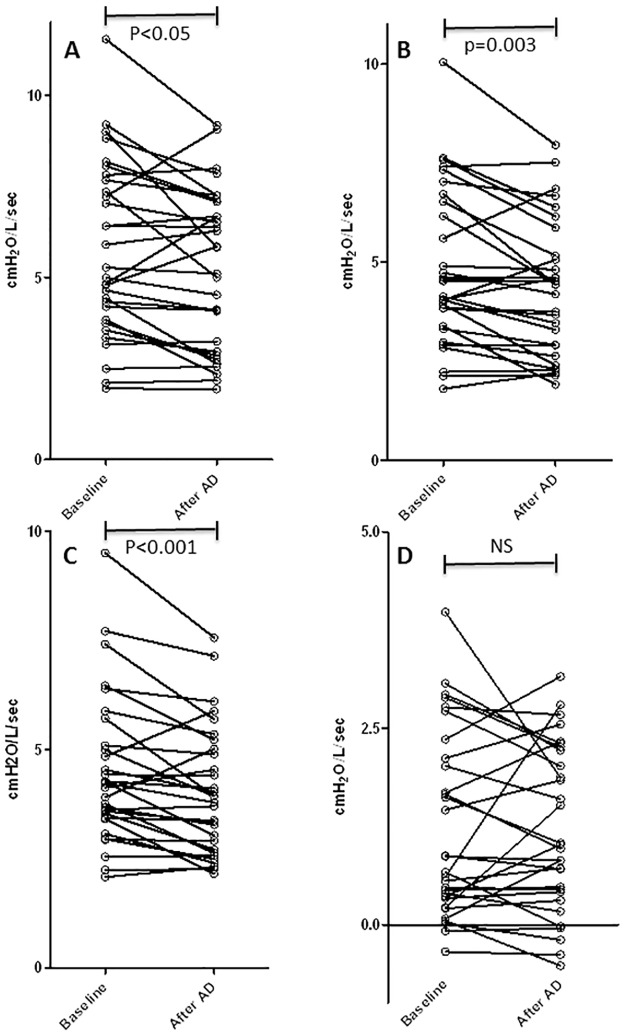
Individual values of inspiratory resistances before and after autogenic drainage in 30 CF patients.A, Rrs5; B, Rrs11; C, Rrs19; D, Rrs5–Rrs19.